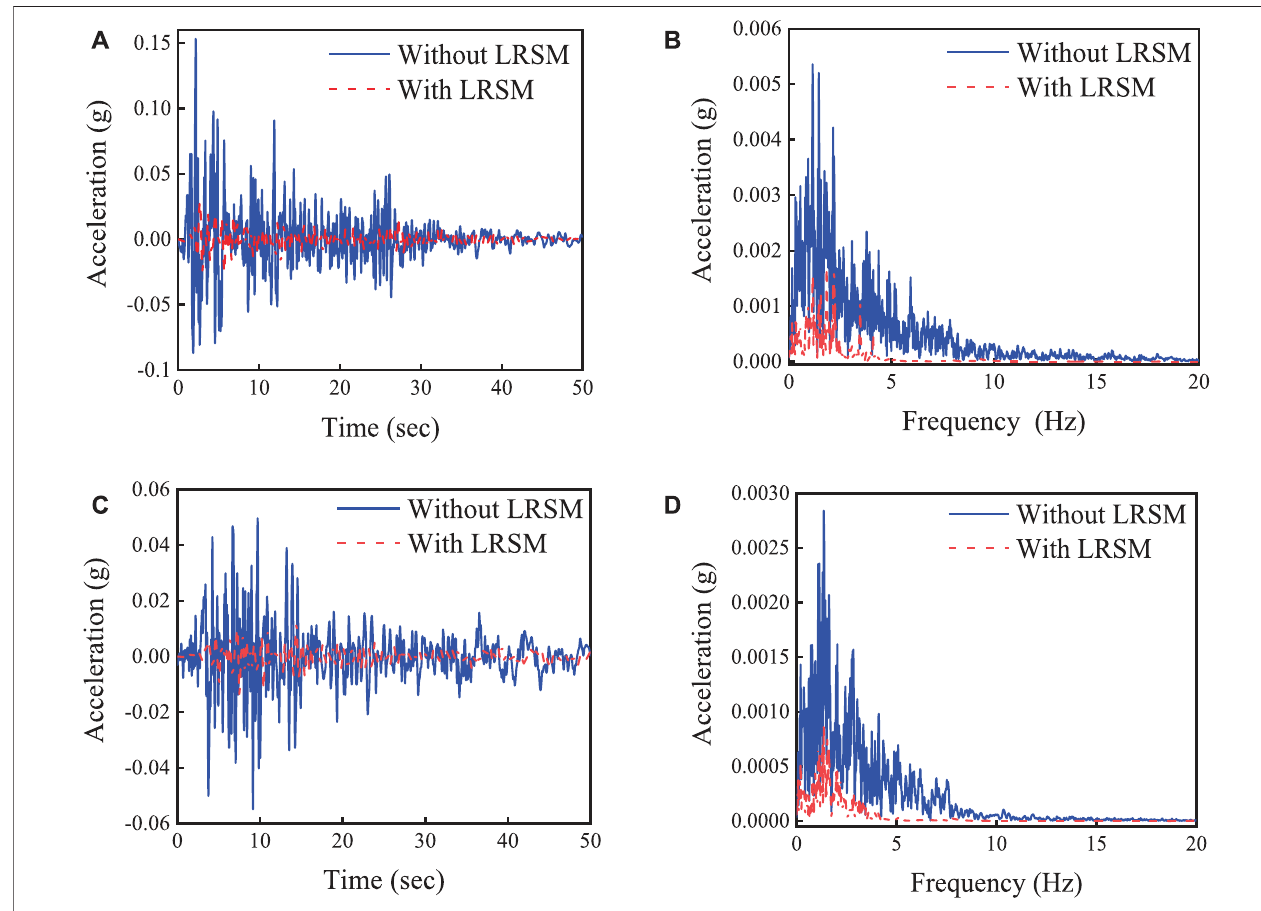
FIGURE 14 | Excitation signal response: (A) excitation signal response of El Centro seismic wave; (B) fourier spectrum of El Centro seismic excitation signal response; (C) excitation signal response of Taft seismic wave; (D) fourier spectrum of Taft seismic excitation signal response.